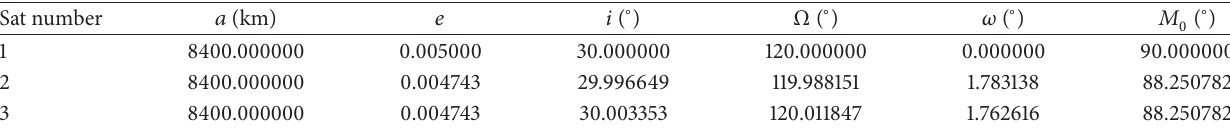
Table 1: Keplerian orbital elements of a satellite formation.